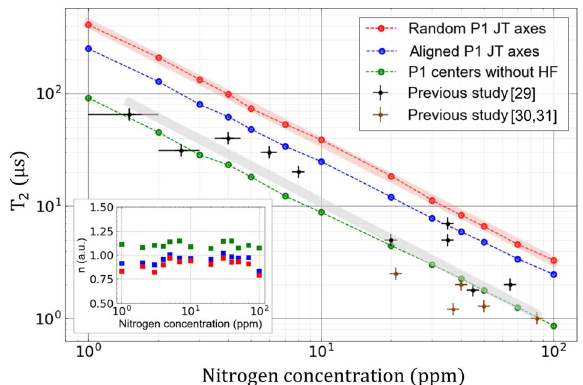
Fig. 2 Coherence times of diamond NV ensembles in a P1 bath. Hahn-echo coherence times (T 2 ) as a function of [P1] with random P1 JT axes (red dots) compared with previous experimental data of T 2 (black 29 and brown 30,31 crosses). An external magnetic fi eld of 500 G was applied along the [111] direction for the computation. Two hypothetical P1 bath models were considered: a P1 bath in which all the JT axes are polarized in the [111] direction (blue dots) and a P1 bath in which the P1 hyper fi ne interaction is ignored (green dots). The gray shaded line is the fi tted line for the experimental data to be compared with the red shaded line, which is the fi tted line for our computational results. Inset: stretched exponential parameters ( n ) for the P1 bath models with no- hyper fi ne interaction (green marker), polarized P1 JT axes (blue marker), and randomized P1 JT axes (red marker).